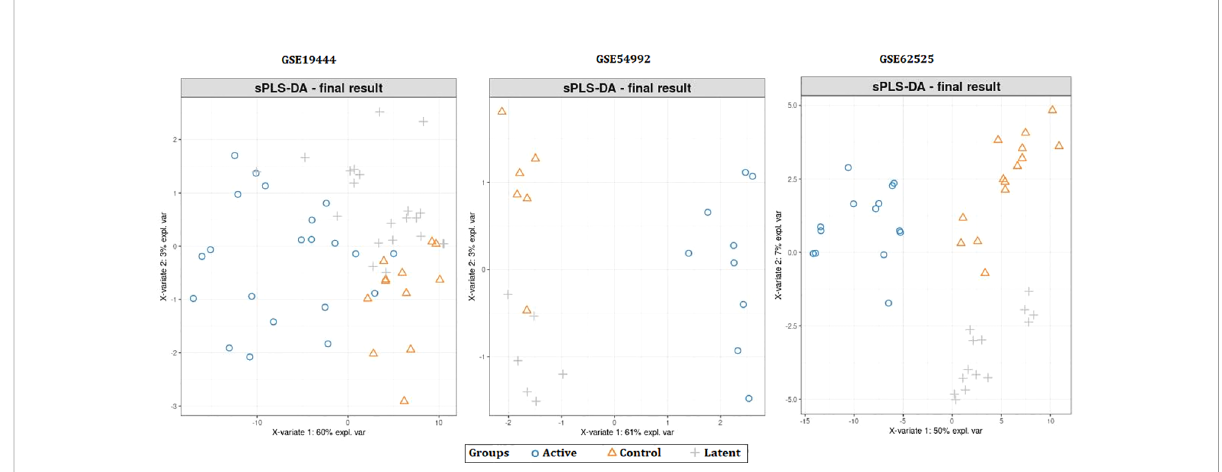
FIGURE 3 Partial least squares-discriminate analysis (PLS-DA) plots showing differentiation between the control and TB